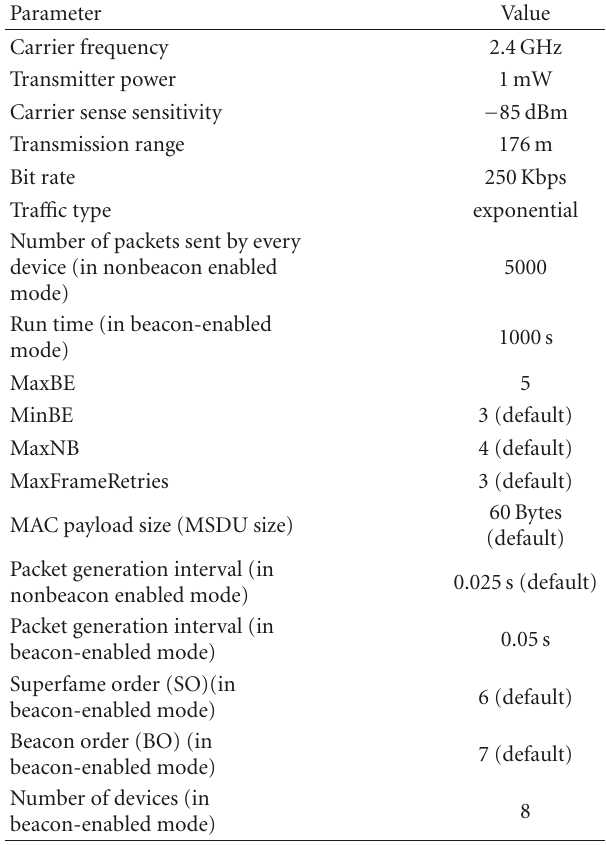
Table 2: Parameter